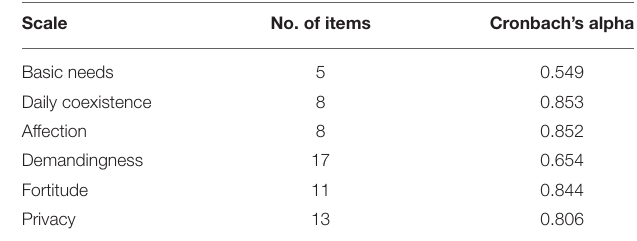
TABLE 2 | Internal consistency of the scales in the preliminary